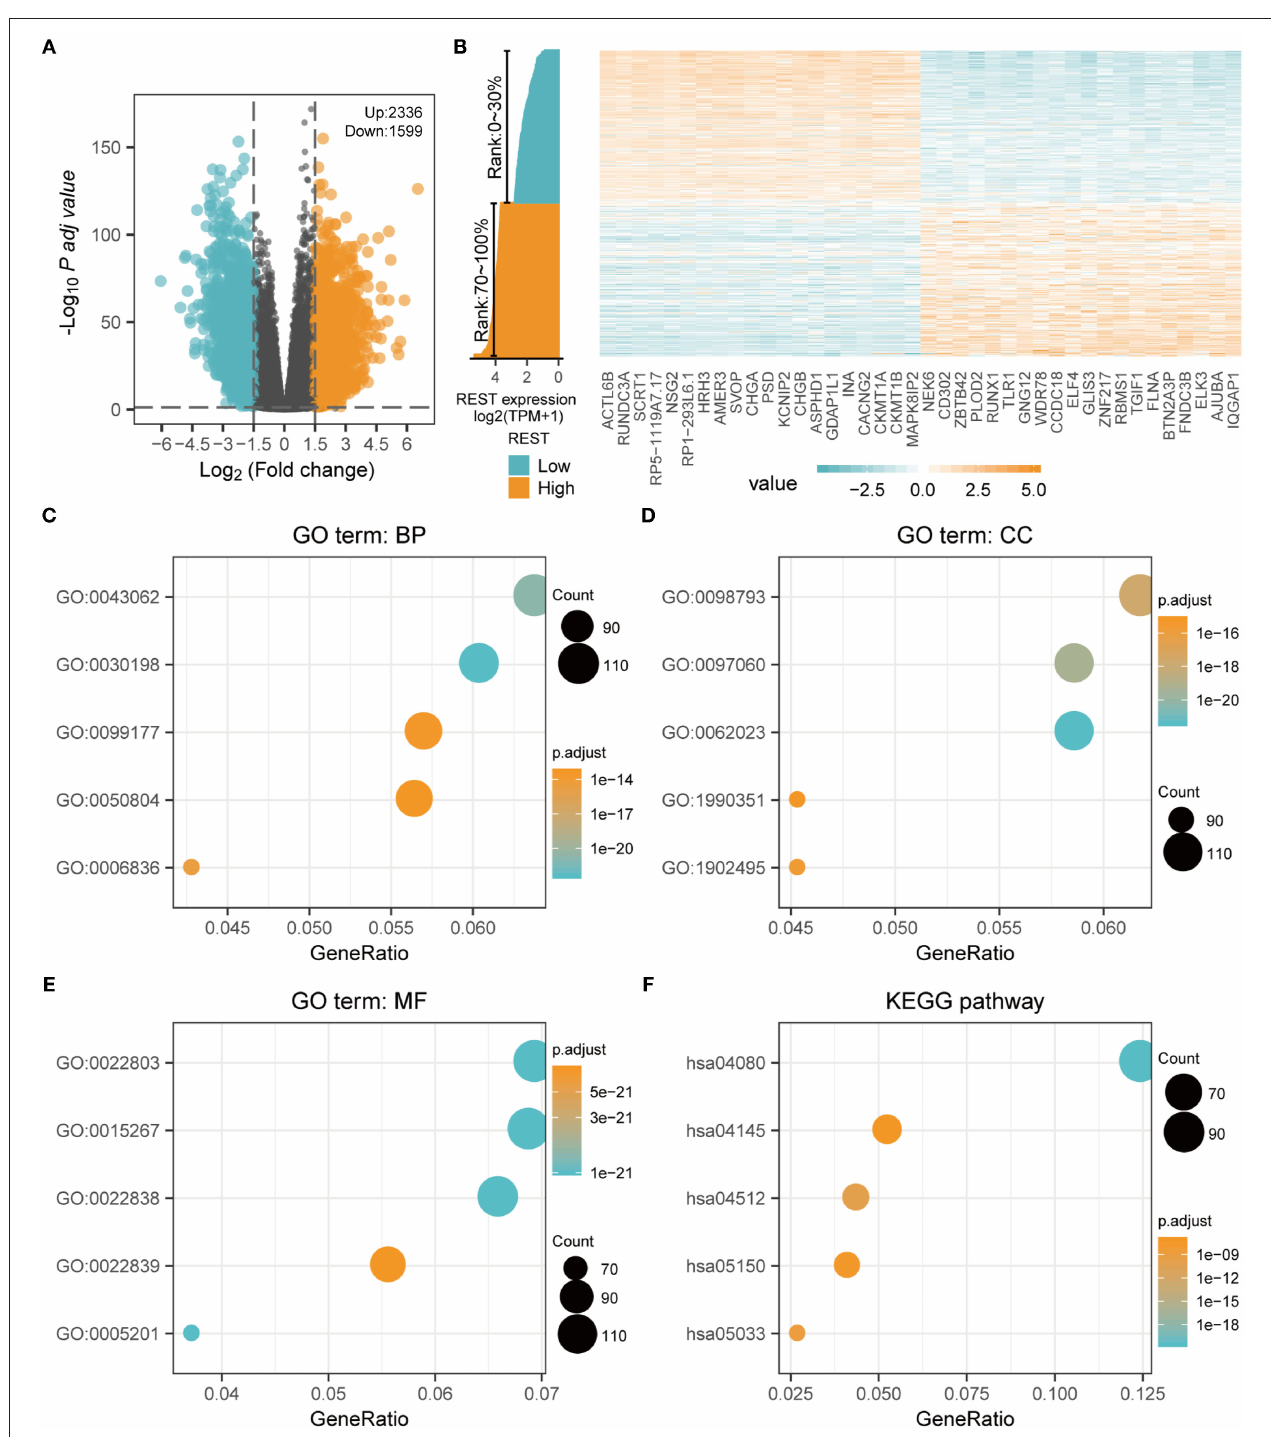
FIGURE 4 | REST-associated differential expression gene analysis (DEGs) and GO/KEGG enrichment analysis. (A) The volcanic map showing the DE-mRNA of the high (top 30%) and low (bottom 30%) REST expression profiles. (B) The heat map showing the top 20 up-regulated and the top 20 down-regulated REST-associated DE-mRNA. (C–F) Functional enrichment analysis of REST associated DE-mRNA. The biological process (C) , cellular component (D) , molecular function (E) , and KEGG pathway (F) were analyzed.